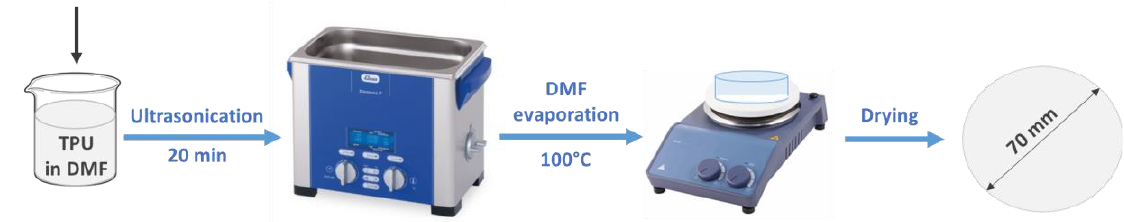
Figure 1. Synthesis method for TPU – TiO 2 NW composites as free-standing films.